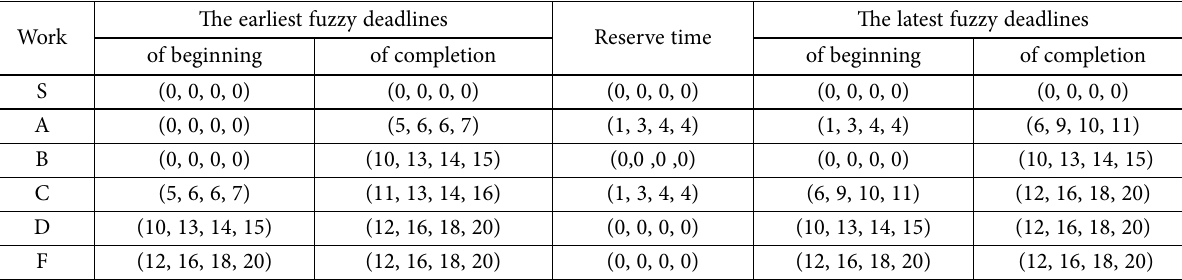
Table 4. Summary of calculation results on the basis of Table